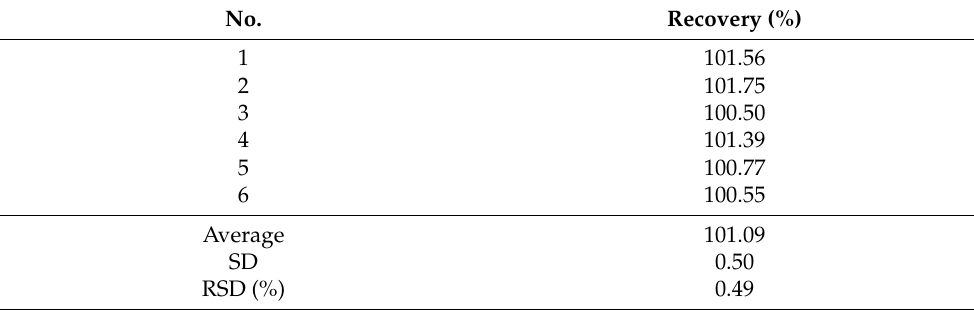
Table 2. Precision data obtained from the developed analytical method for P18. No.